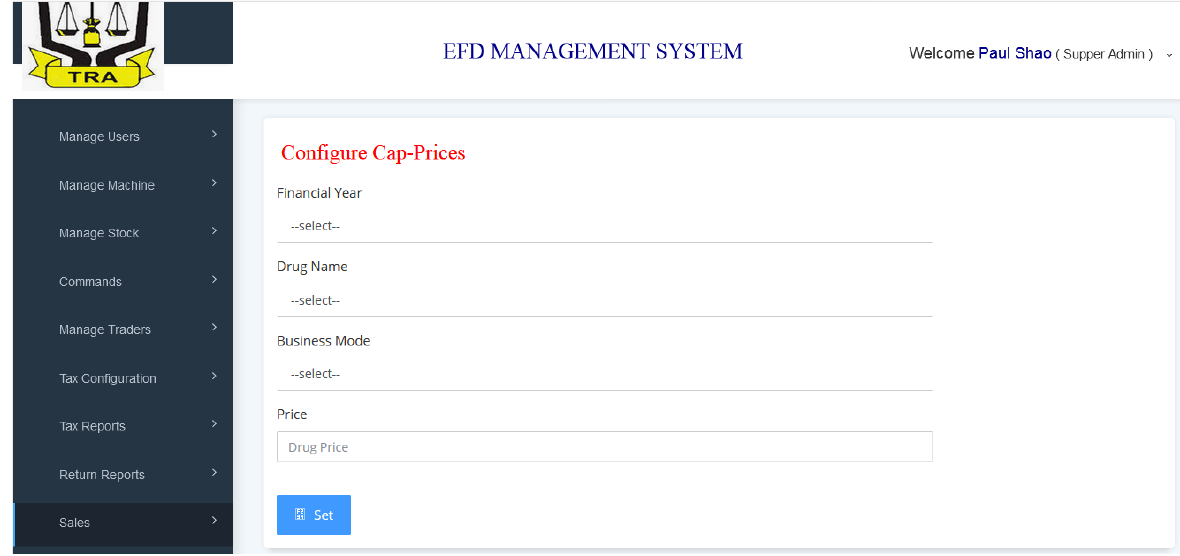
Figure 12. Tax Officer Configuring Cap-Prices